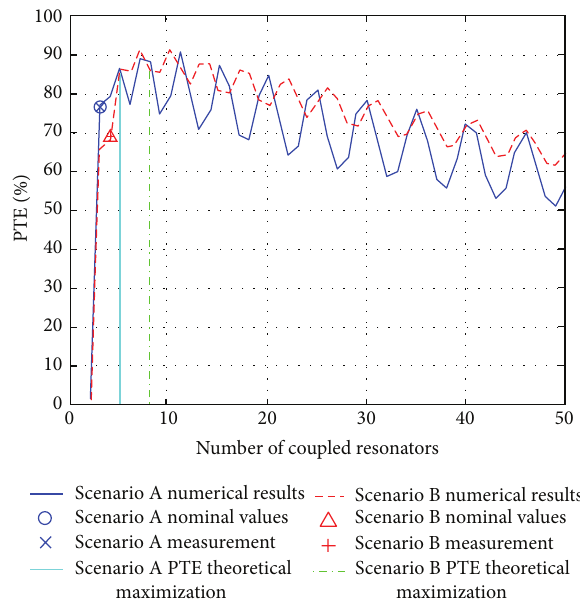
Figure 6: PTE versus coupled resonator number for two different DCR configuration scenarios.